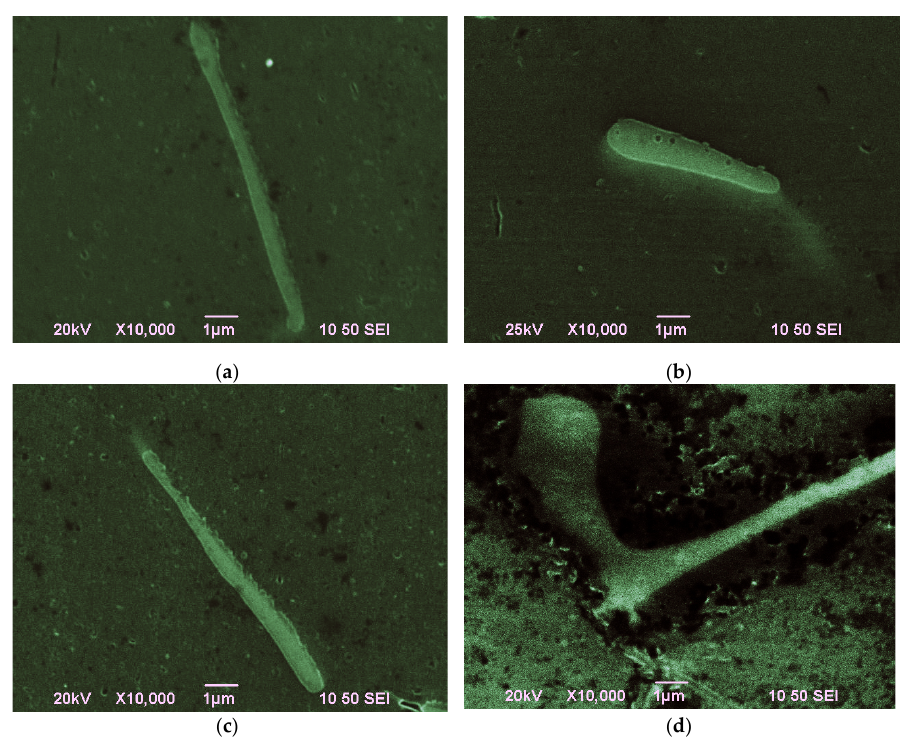
Figure 3. Images indicating the rounding of the edges of the particles after 2 h holding time. ( a ) Long elongated particle; ( b ) short particle; ( c ) elongated particle and ( d ) particle with segment.